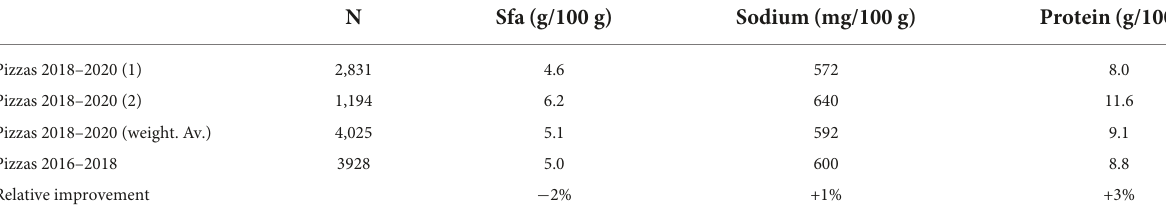
TABLE 2 Total of 4,025 products in Mintel category “Pizzas” for the period 2018-20, with nutritional thresholds for the two nutritionally homogenous subcategories and their weighted average (e.g., Mean Sodium threshold = 592 mg/100 g = (572*2,831 + 640*1,194)/4,025), and comparison with the thresholds of the 3928 pizzas of